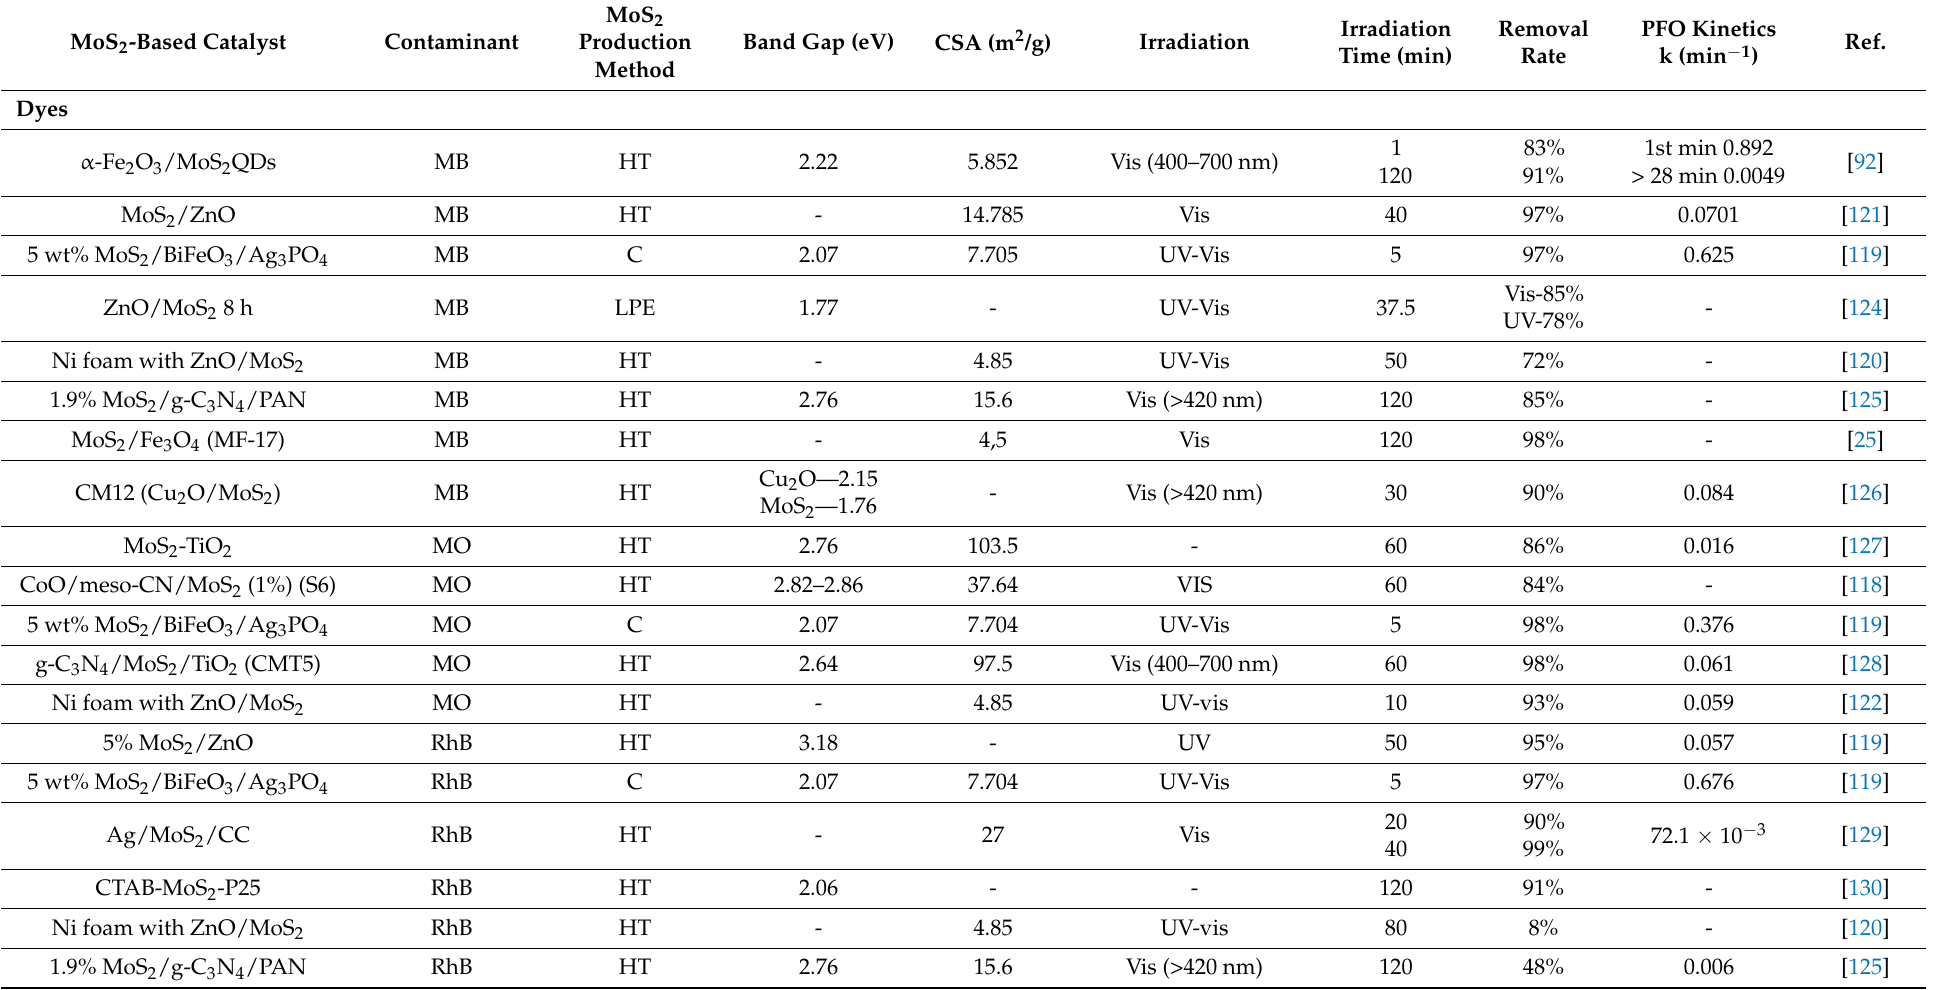
Table 2. Characteristics of MoS 2 -based catalysts and the respective photocatalytic performance (in optimized